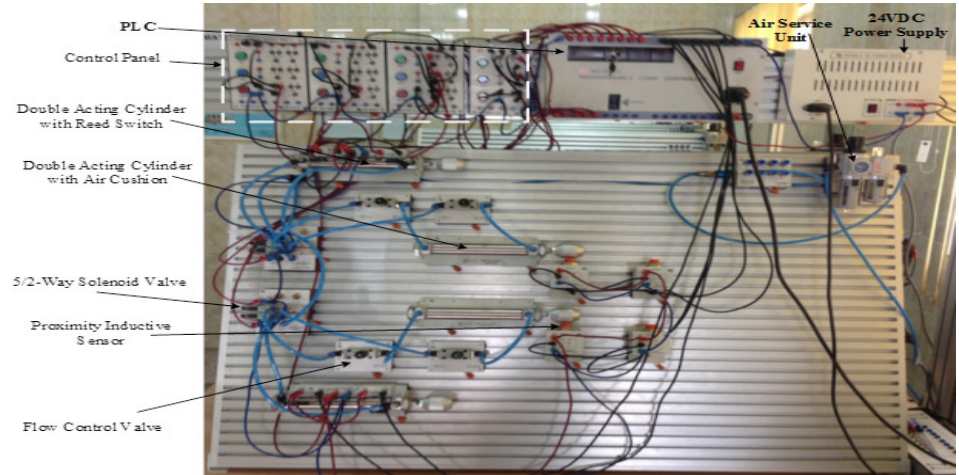
Fig. 1. Experimental Setup of PPS Control System.